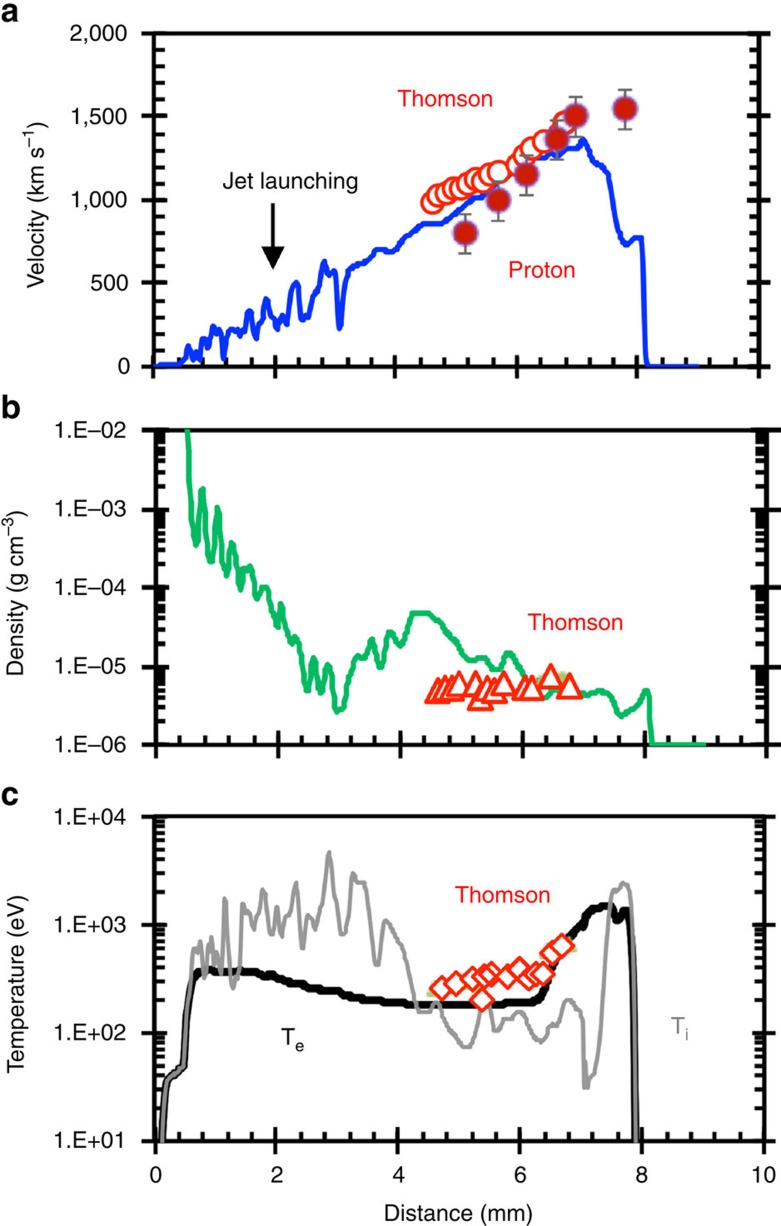
Comparison between measurements and numerical simulation.(a) Measured jet velocities (solid circles by protons (Fig. 1c) and open circles by Thomson-scattering (Supplementary Fig. 3), with measurement uncertainties (error bars) discussed therein, respectively), plotted as a function of position in the jet flow compare well with simulated values (blue line). The error bars of proton measured jet velocities indicate Δv∼±80–120 km s−1, including measurement uncertainties and consequences of proton Coulomb scatterings. The increase in the simulated jet velocity as the flow propagates outwards, is a consequence of the gradient in the thermal plasma pressure, and leads to the decrease in the simulated jet density shown in (b) (green line). The measured plasma densities inferred from the Thomson-scattering data, which are shown as open red triangles, agree reasonably with those of the simulation. (c) The plasma temperatures T inferred from Thomson-scattering measurements (assuming Te∼Ti, in this relevant region, see Supplementary Fig. 3)2944, which are shown as open red diamonds, compare reasonably well with those of the simulation (black line).